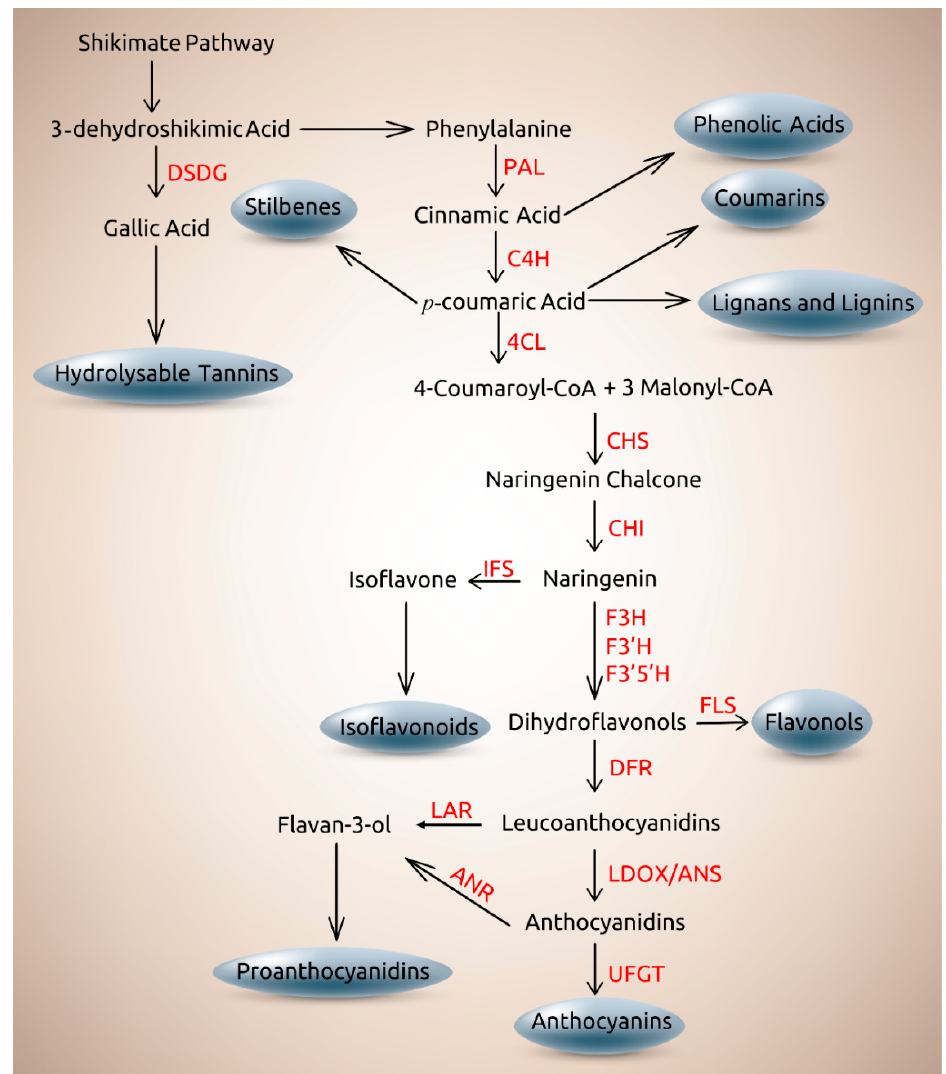
Figure 3. Adapted from the literature [56,89,90,92–95]. DSDG, dehydroshikimate dehydrogenase; PAL, phenylalanine ammonia-lyase; C4H, cinnamate 4-hydroxylase; 4CL, 4-coumarate:CoA ligase; PAL, phenylalanine ammonia-lyase; C4H, cinnamate 4-hydroxylase; 4CL, CHS, chalcones synthase; CHI, chalcone isomerase; F3H, flavanone 3-hydroxylase; F3 ′ H, flavonoid